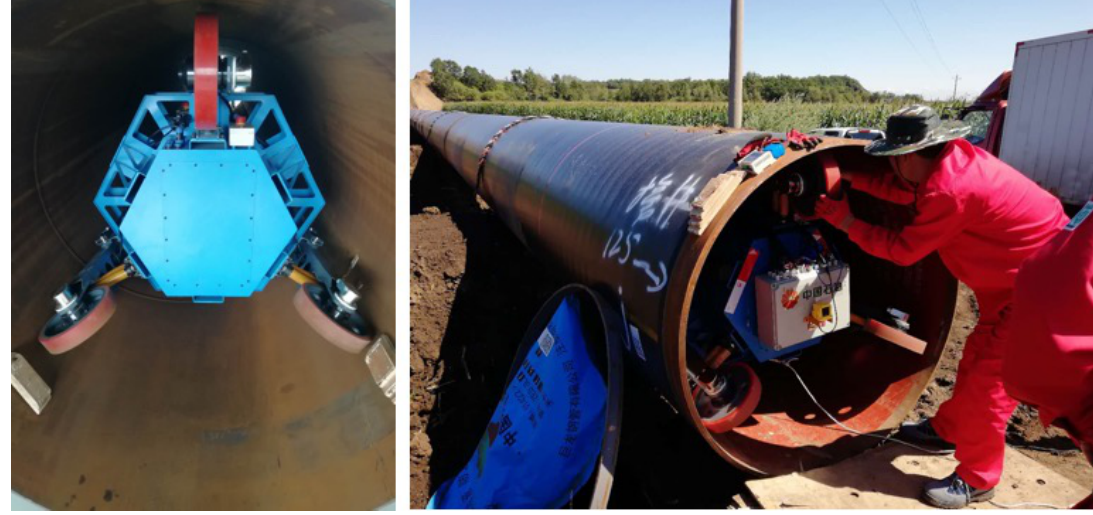
Figure 3. Operation scenes of previous inspection